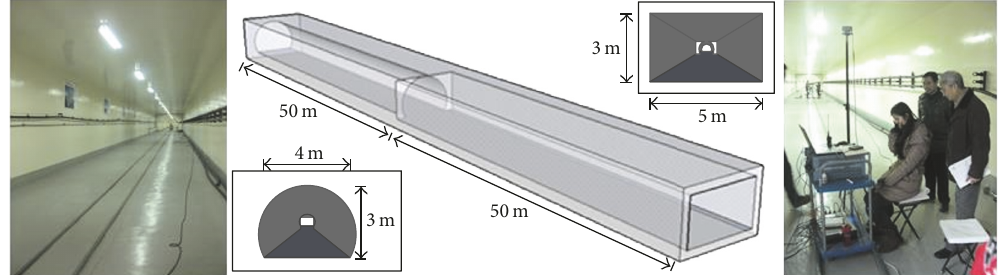
Figure 1: Tunnel laboratory in Zhongtian Technology Group.